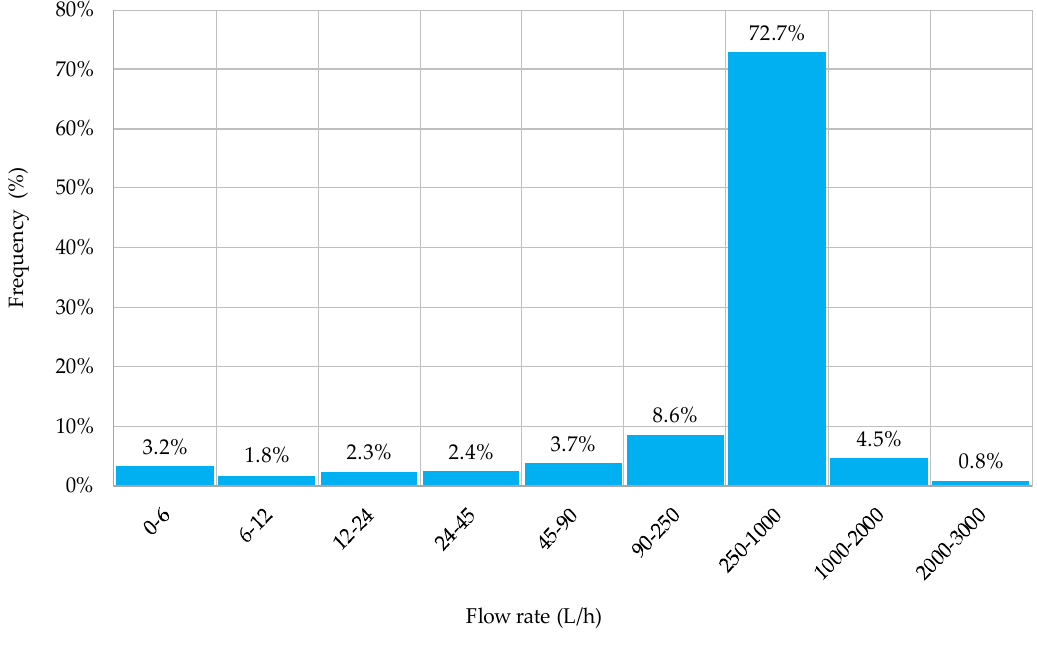
Figure 2. The frequency distribution for the consumption flow rates of the monitored residential users.